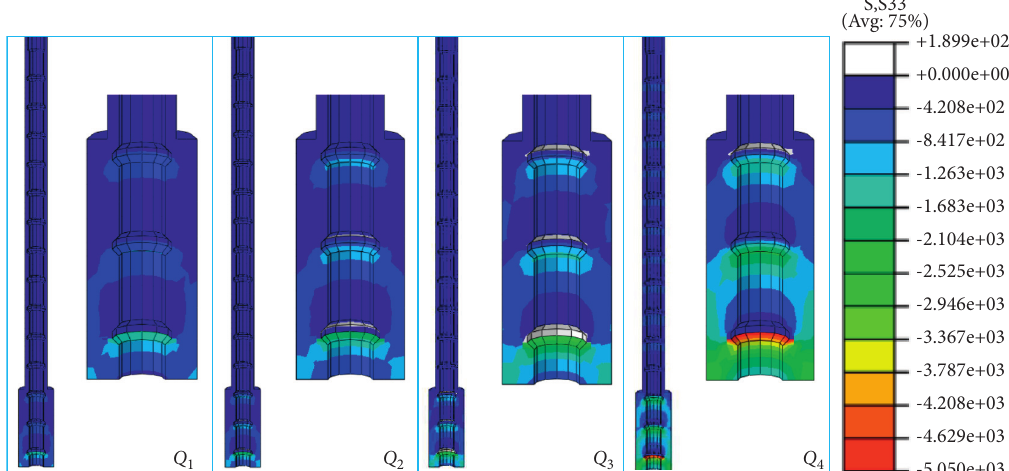
Figure 8: Vertical stress change of cement soil at the enlarged base during